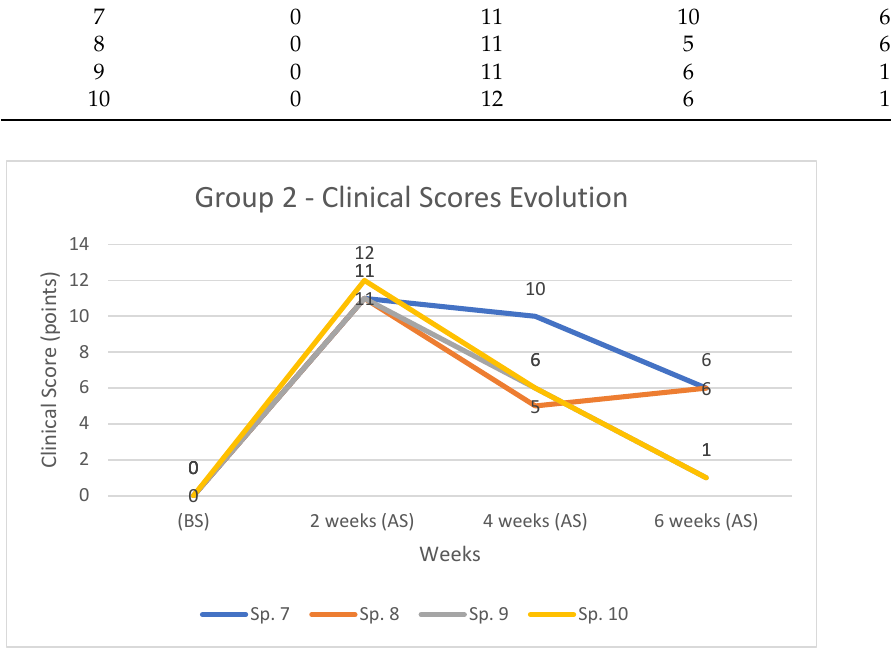
Figure 14. The evolution and comparison of clinical score for cases in group 2, (BS) and (AS) at 2, 4, and 6 weeks respectively.